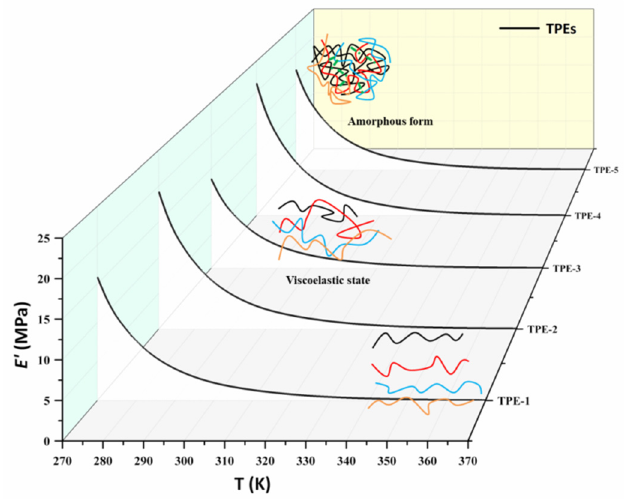
Figure 5. Elastic modulus of TPEs as a function of temperature.